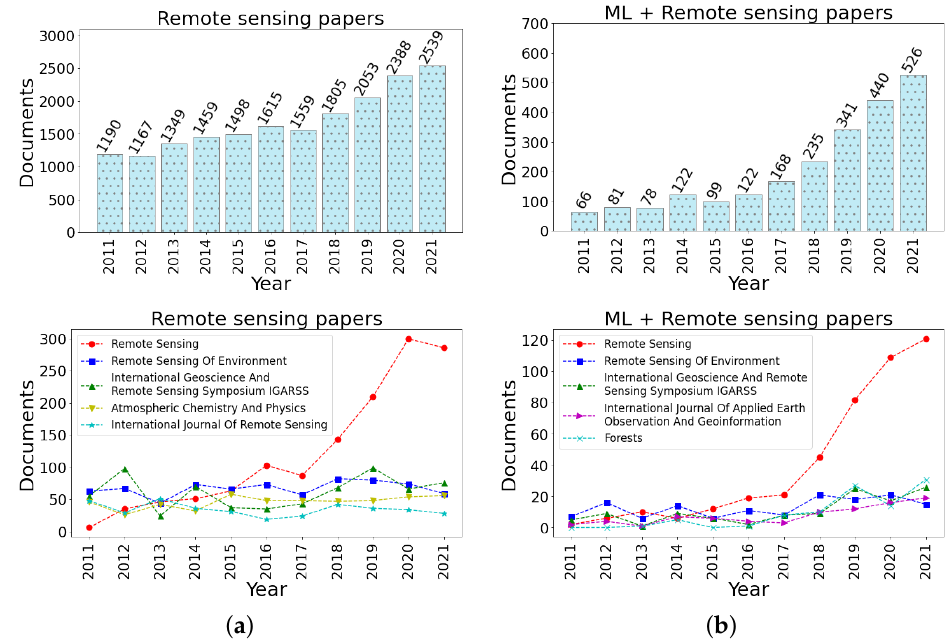
Figure 1. Year wise publication of remote sensing papers for forest characteristics extraction: number of publications per year; the most popular journals according to the number of publications. The data was retrieved from the Scopus database [27]. ( a ) General search that include remote sensing for forest tasks keywords; and ( b ) intersection of general remote sensing search for forest tasks results with ML-specific